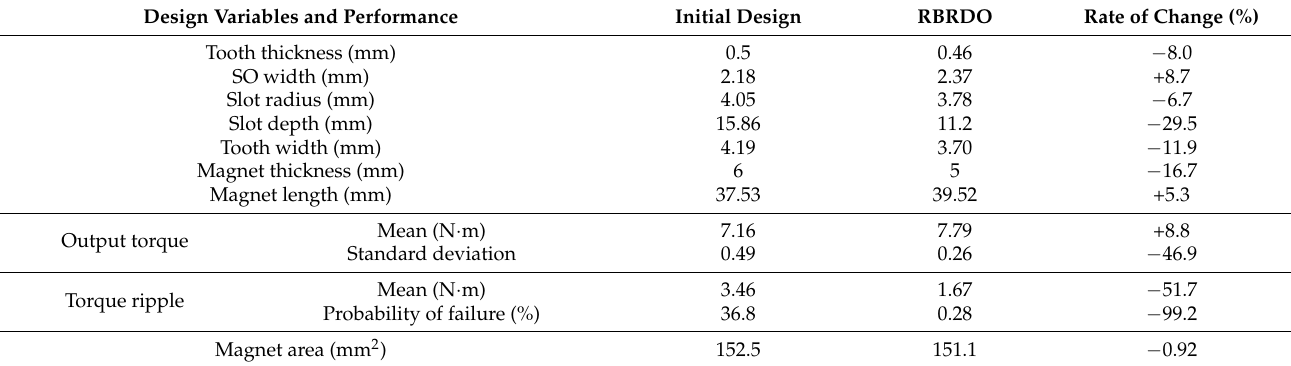
Table 6. Comparison of the design variables and performances in the initial design and RBRDO.